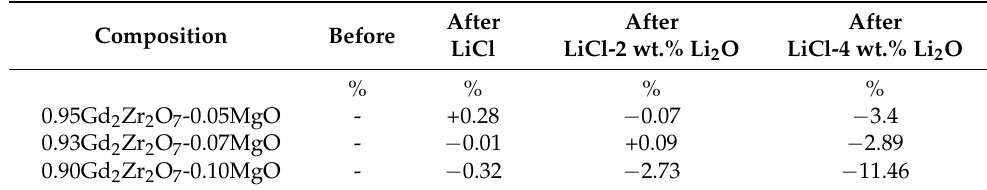
Table 5. Change in the mass loss of ceramic samples of (1- x )Gd 2 Zr 2 O 7 · x MgO before and after exposure in LiCl- x Li 2 O melts at T = 650 ◦ C.